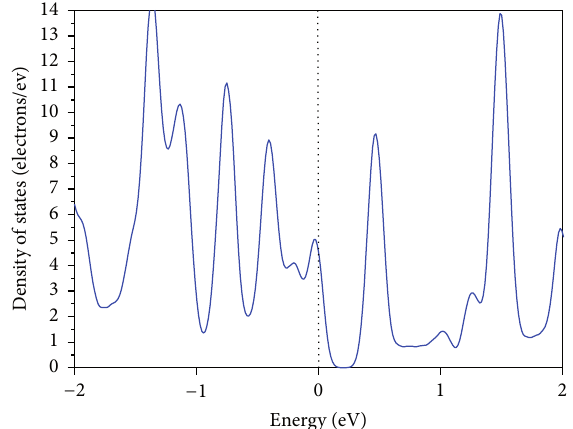
Figure 8: Density of states (DOS) of N1-doped single walled zigzag (5,0) BNT. The Fermi energy is set corresponding to zero energy and represented by dotted line.